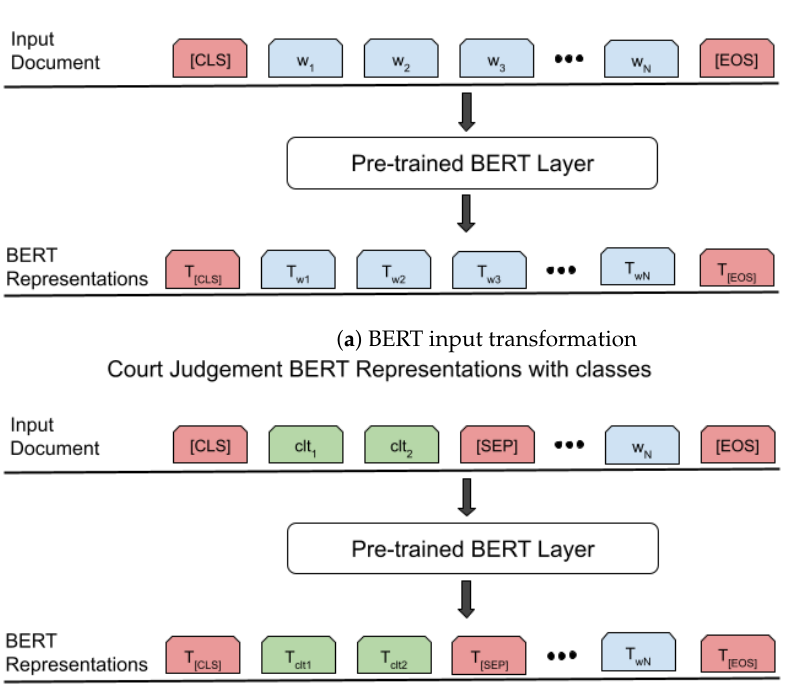
Figure 5. ( a ) BERT input transformation; ( b ) BERT input transformation with class information. The BERT input transformation with class information involves adding special tokens to indicate the class of the input text and separating the class information from the original text using the [SEP] token. The tokens in blue correspond to words in the input text, those in red to special tokens, and those in green to class